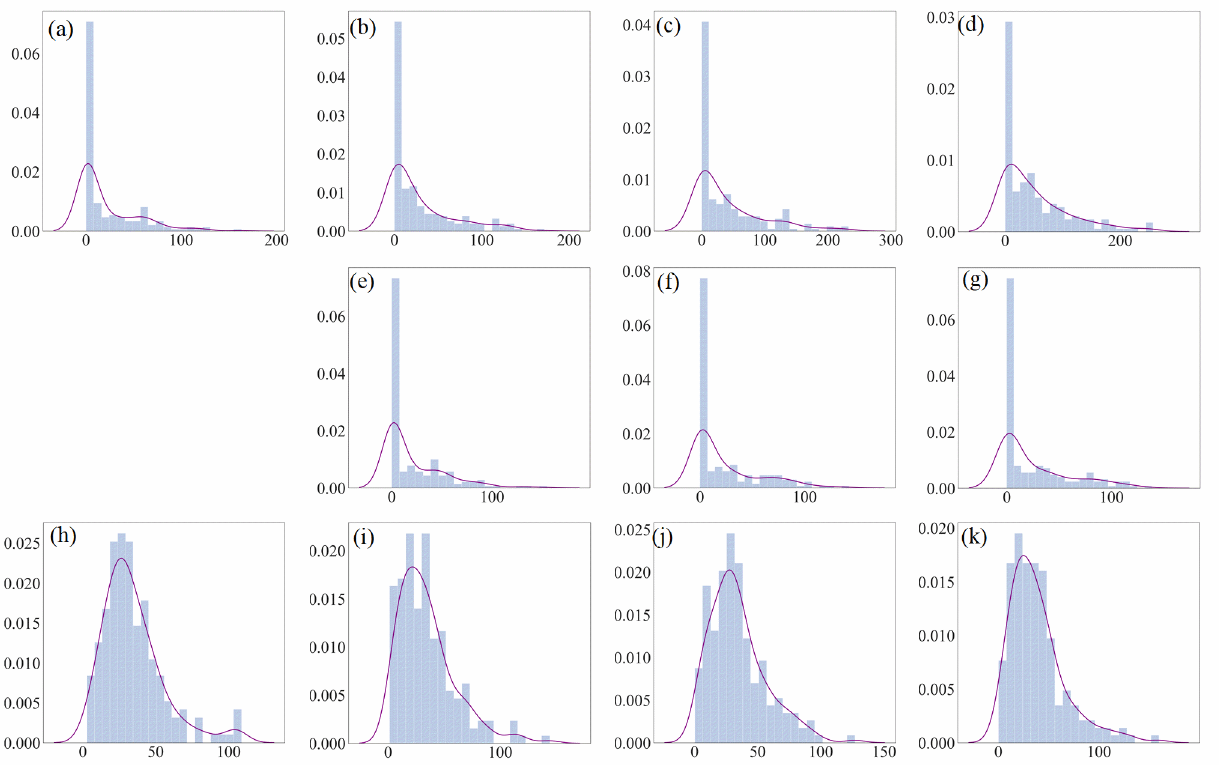
Figure 9. Changes in PDF during the successive adjustments of precipitation based on the GCM MPI simulations at the Naqu site. Precipitation is displayed as an example of mismatching PDF between the observations and the GCM simulations. The upper row indicates the control observations (( a ), 1955–1969)) and the calibrated results of the three adjustments ( b – d ). The center row ( e – g ) indicates the observations for validating the calibrated results for the corresponding projection periods. The bottom row ( h – k ) indicates the raw GCM simulations in the corresponding periods. The first column: control period (1955 – 1969); the second to fourth columns: the first (1970 – 1984), second (1985 – 1999) and third (2000 – 2014) adjustments, respectively. The solid line indicates a distribution fit to the data.